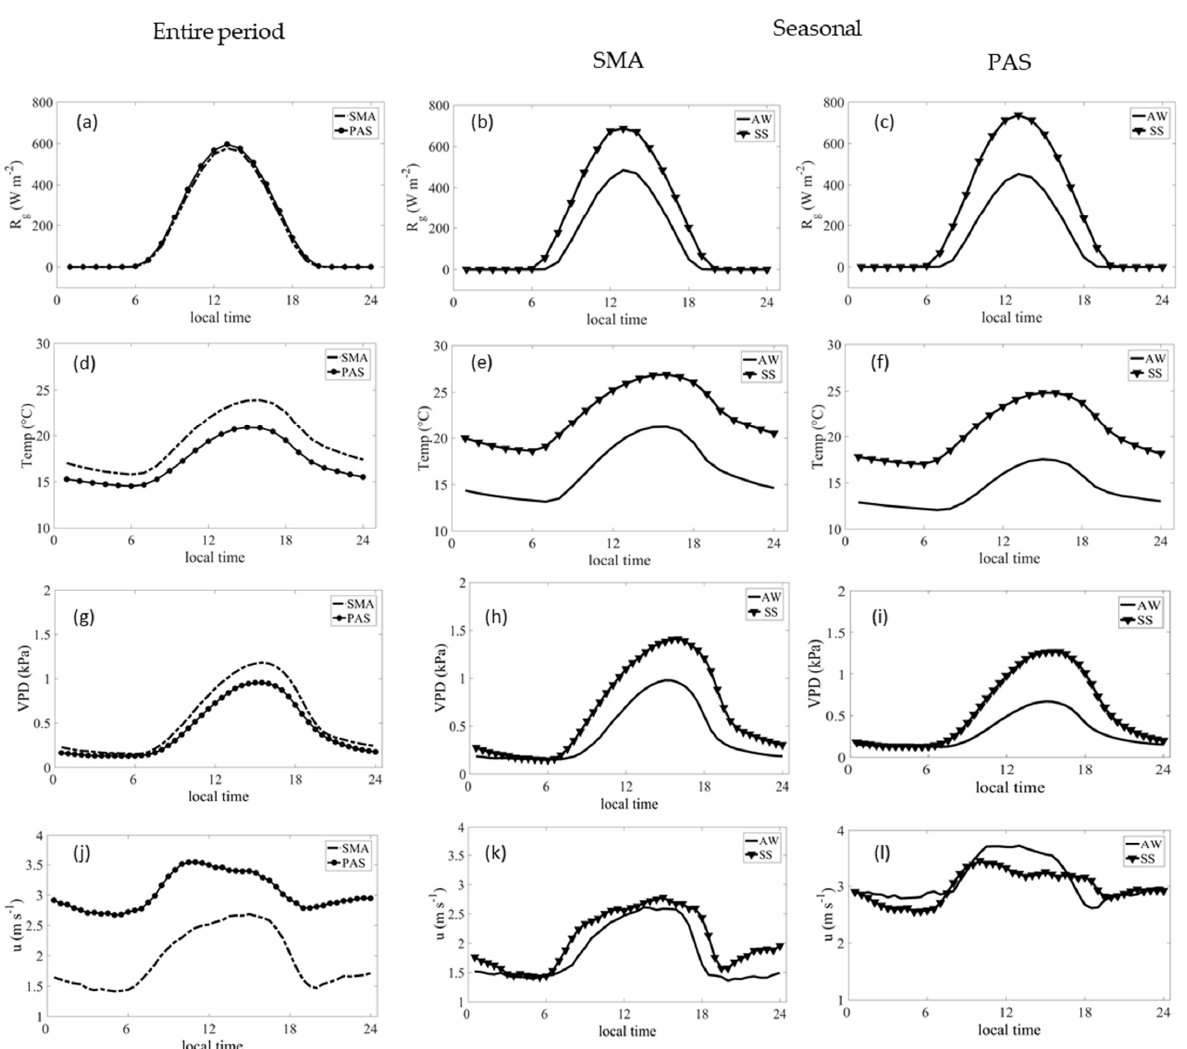
Figure 2. Daily cycles of meteorological variables: solar radiation ( Rg , W m − 2 ) ( a – c ); air temperature ( Temp , °C) ( d – f ); vapor pressure deficit ( VPD , kPa) ( g – i ); wind velocity ( u , m s − 1 ) ( j – l ); on the left column for the entire study period, on central for SMA in the AW and SS periods, and the right for PAS in AW and SS periods.